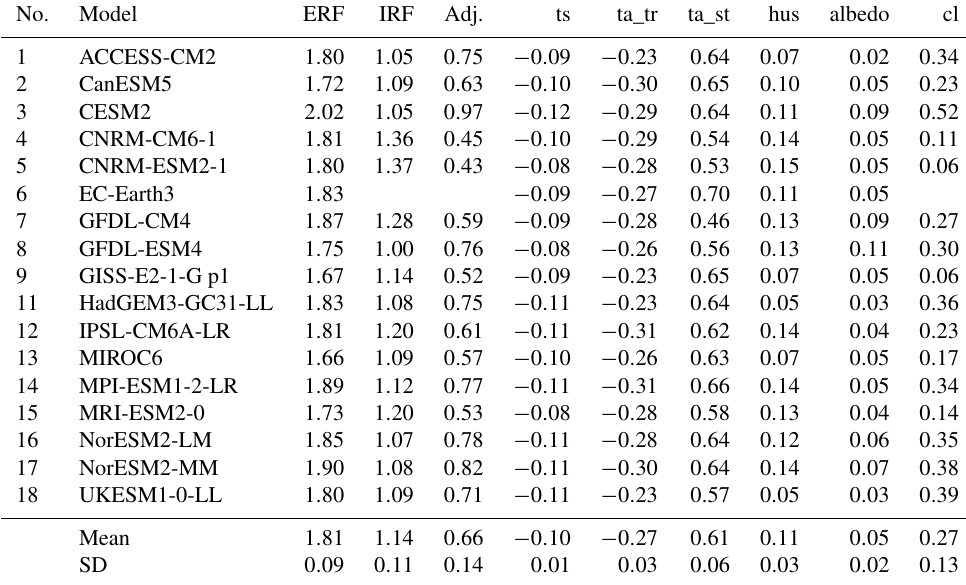
Table 3. ERF, IRF and adjustments (Wm − 2 ) by component from 1 . 4 × CO 2 , scaled down from the 4 × CO 2 RFMIP experiment. Adj.: adjustment; ts: surface temperature; ta_tr: tropospheric temperature; ta_st: stratospheric temperature; hus: water vapour; albedo: surface albedo; cl: clouds.